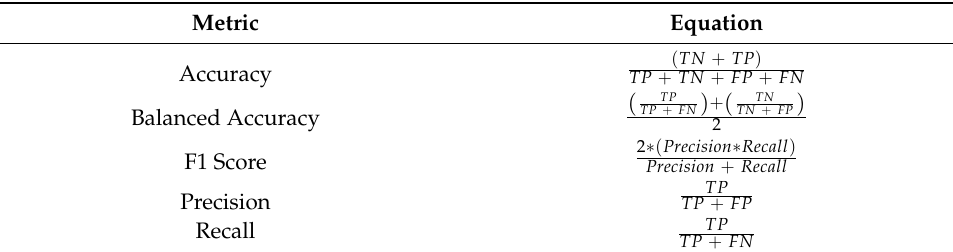
Table 2. Summary of performance